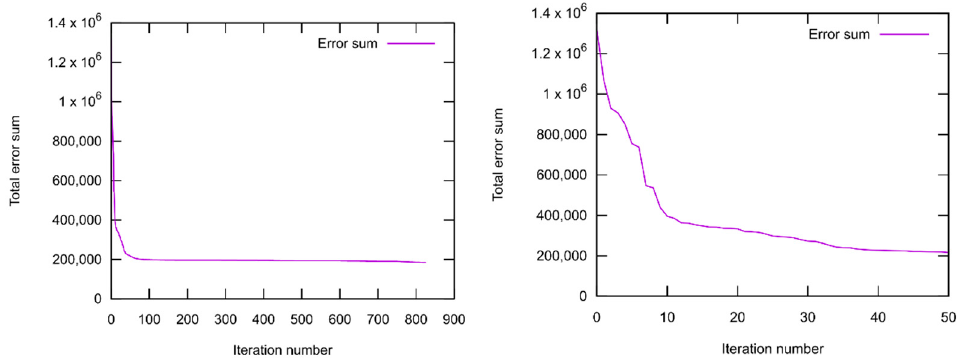
Figure 1. Result of the ReaxFF parameter optimization with OGOLEM. Shown is the error sum (Equation (3)) for the EA iterations, where the right figure is zoomed into the first 50 iterations.